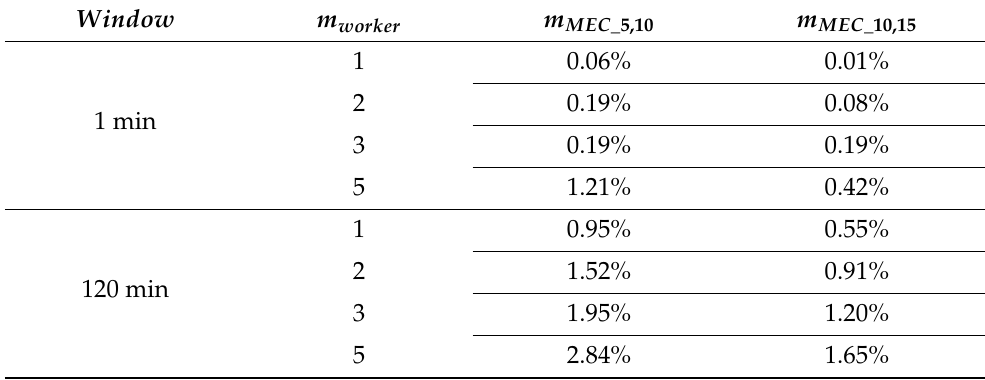
Table 3. Influence of the parameter m MEC on the total savings.